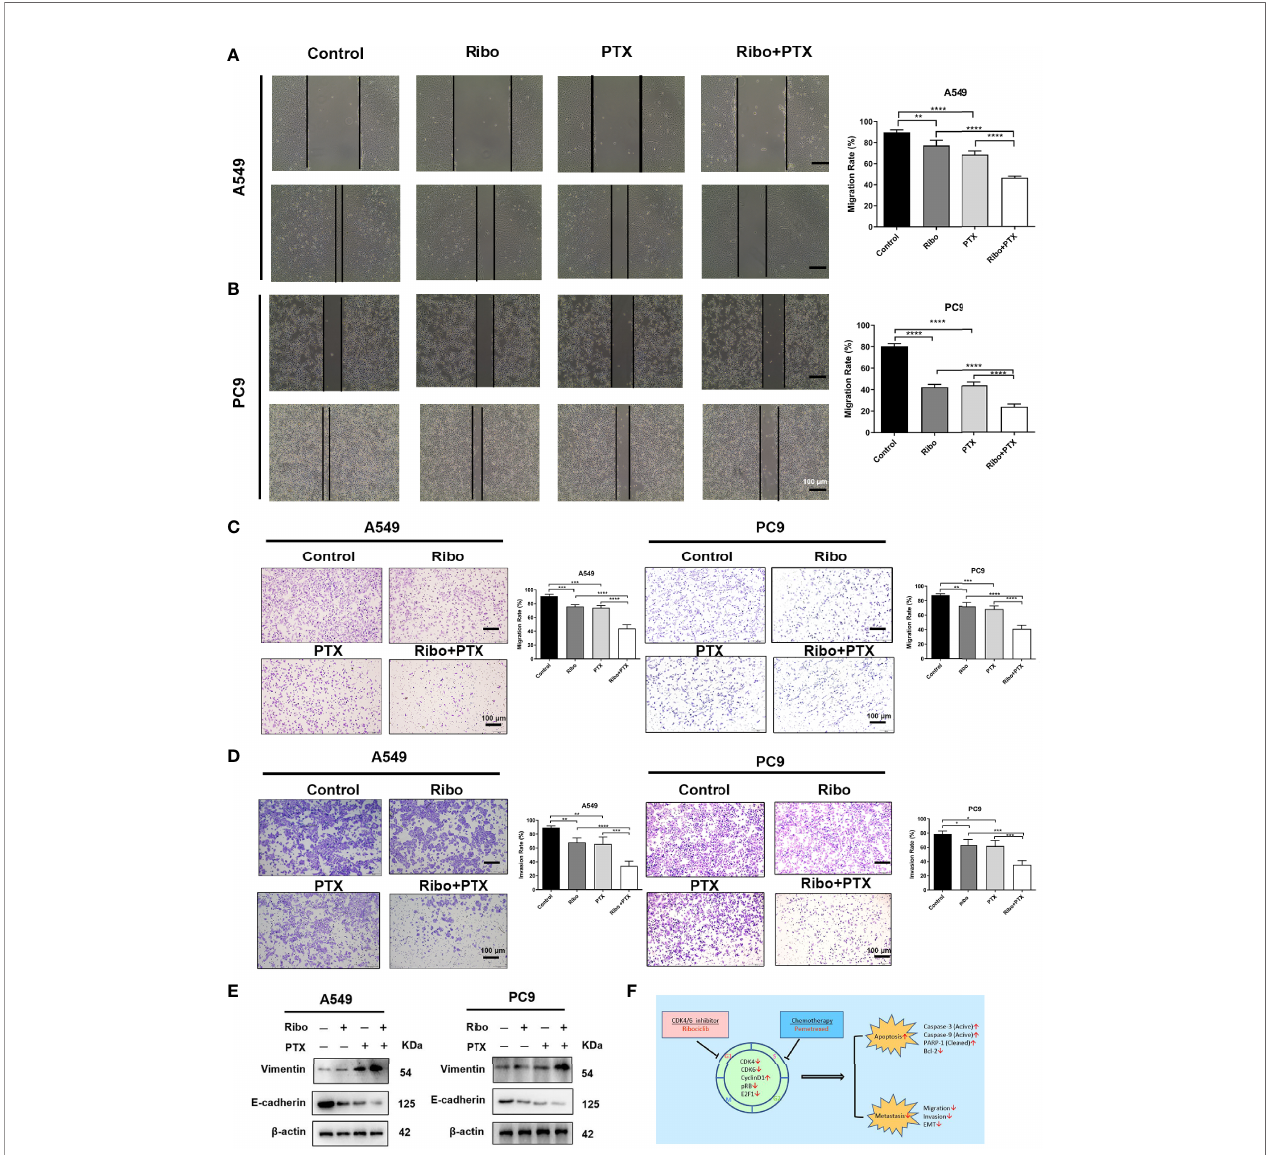
FIGURE 5 | The inhibition effect of ribociclib plus pemetrexed on the migration and invasion of A549 and PC9 cells. (A, B) Representative images and quanti fi cation of wound healing assay results using A549 and PC9 cells. (C, D) Representative images and quanti fi cation of transwell migration and invasion assays results using A549 and PC9 cells. (E) The EMT-related protein molecules were analyzed using western blotting in A549 and PC9 cells. The scale bars represent 100 m m. Data are presented as mean ± SD of triplicate experiments (*p < 0.05, **p < 0.01, ***p < 0.001, and ****p < 0.0001). (F) Summary of the effects of treatments with ribociclib and pemetrexed on their molecular targets and the different observed outcomes. EMT, epithelial to mesenchymal transition; SD, standard